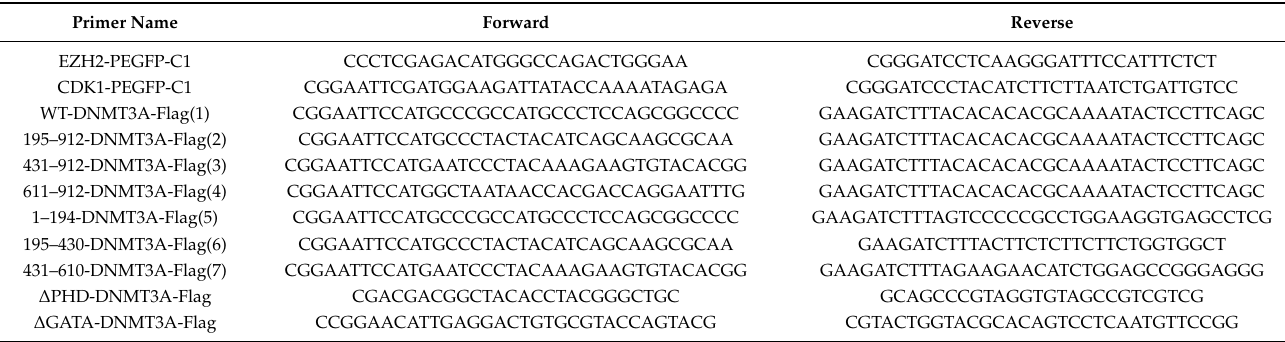
Table 1. Primers are listed in table